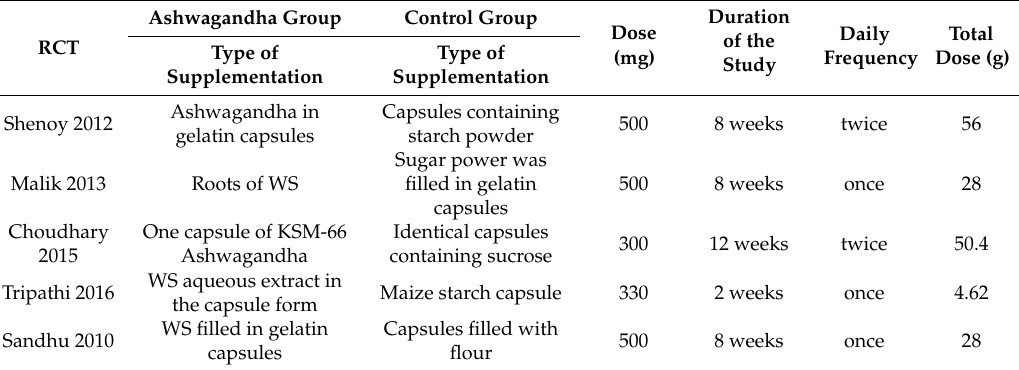
Table 2. Characteristics of the